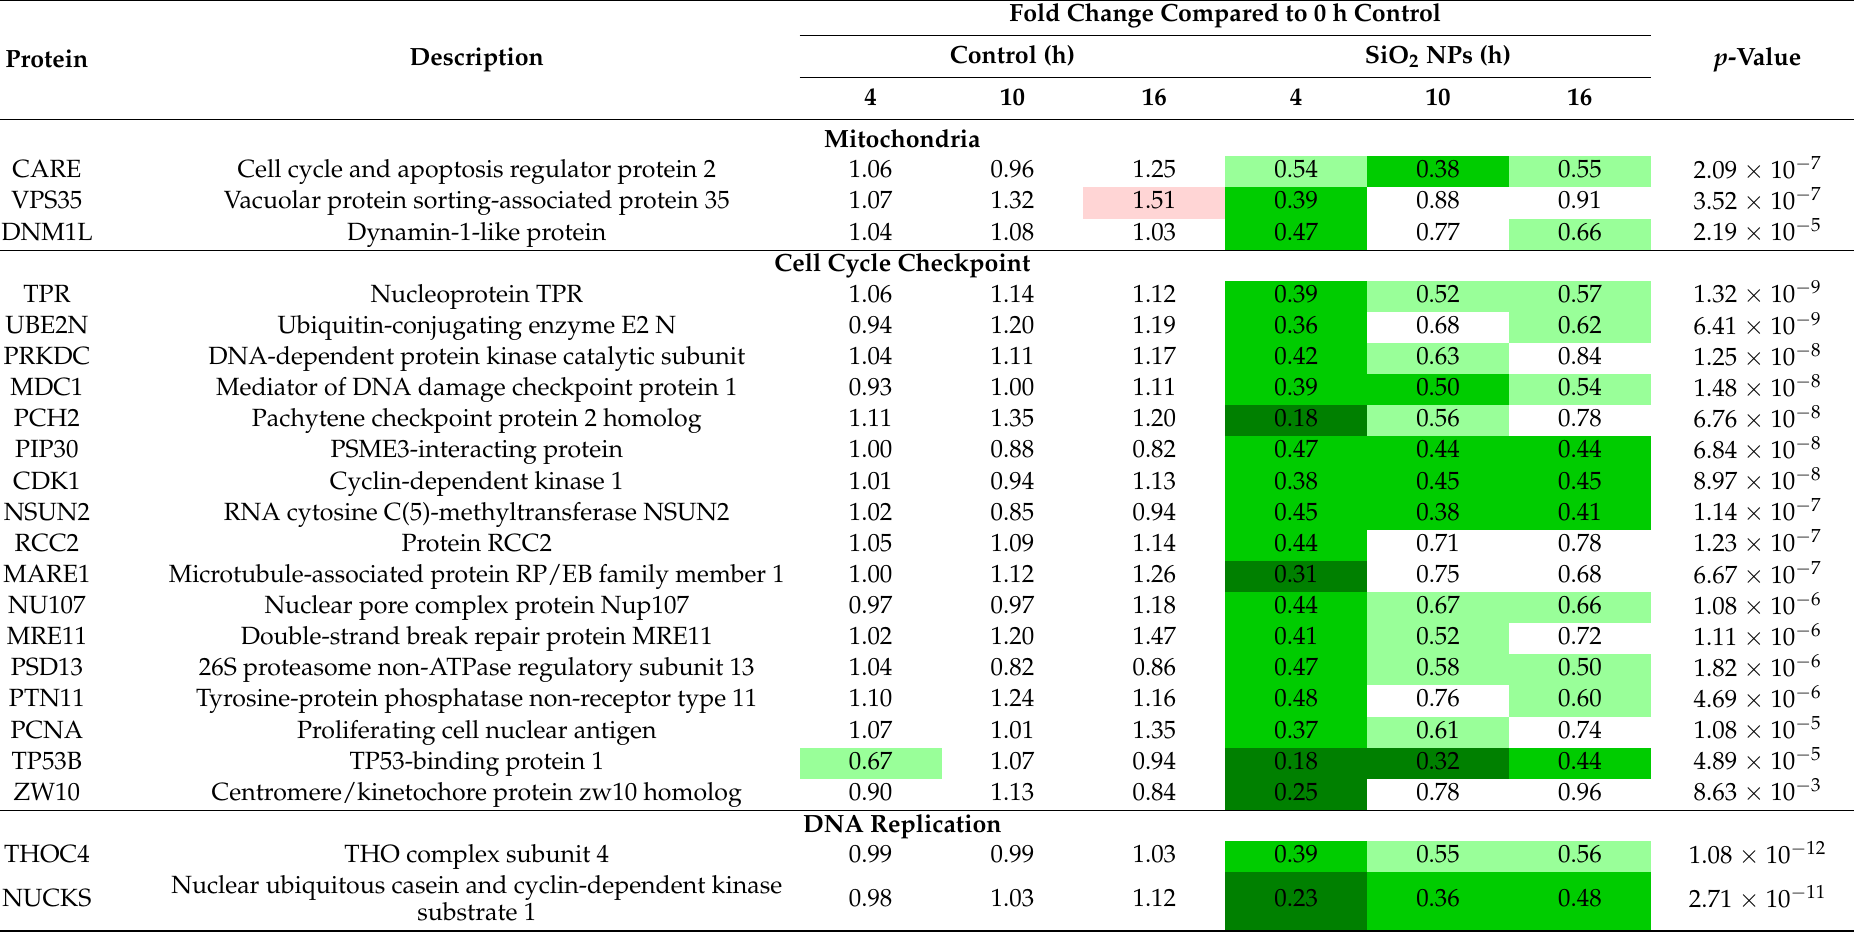
Table 2. List of downregulated proteins from control and SiO 2 NP groups of HepG2 cells by the exposure time associated with the biological pathway.